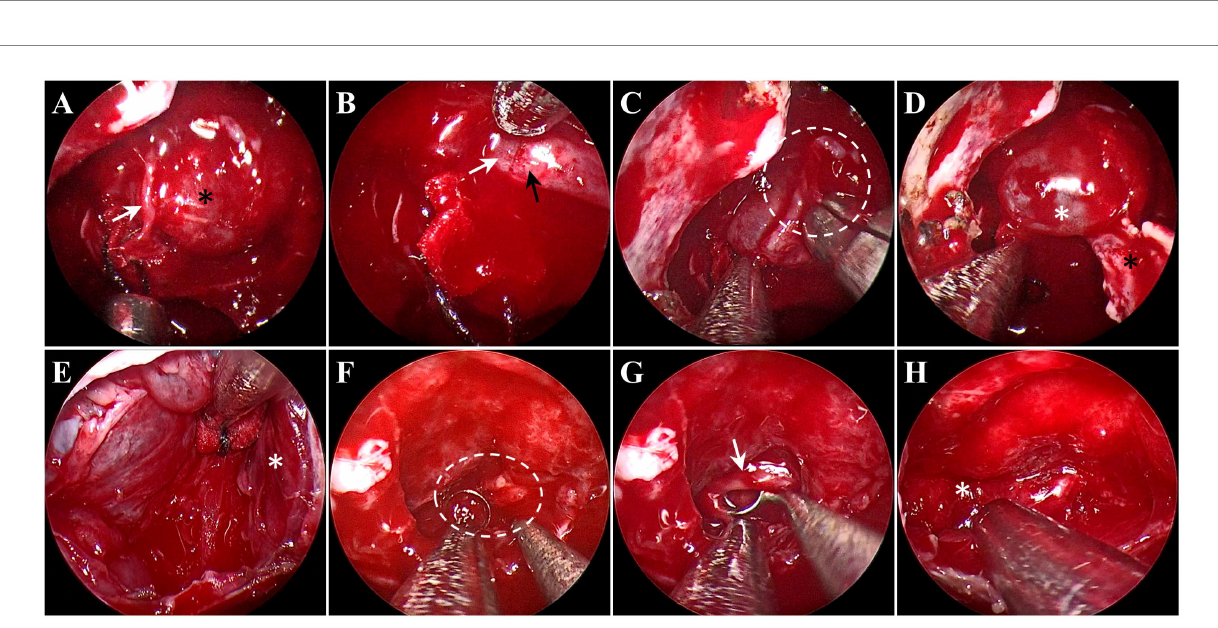
FIGURE 2 Endoscopic intraoperative views in the areas without pseudocapsule. (A–E) Intensive excision bounded by the dural envelope illustrated through case 2. (A) There was no pseudocapsule between the tumor tissue (black asterisk) and the pituitary capsule (white arrow). (B) The surgical plan established between the pituitary capsule (white arrow) and the diaphragma sellae (black arrow). (C) An incision (white circle) was made in the pituitary capsule to control the extent of the pituitary capsule-based extracapsular resection. (D) The tumor tissues and pituitary capsule (white asterisk) peeled off from the diaphragma sellae (black asterisk). (E) After intensive excision, the pituitary gland (white asterisk) on the left side was preserved. (F–H) Intensive excision bounded by the pituitary gland illustrated by case 8. (F) No pseudocapsule was detected (white circle). (G) The tumor tissues (white arrow) were removed, bounded by the pituitary gland. (H) The pituitary gland (white asterisk) was